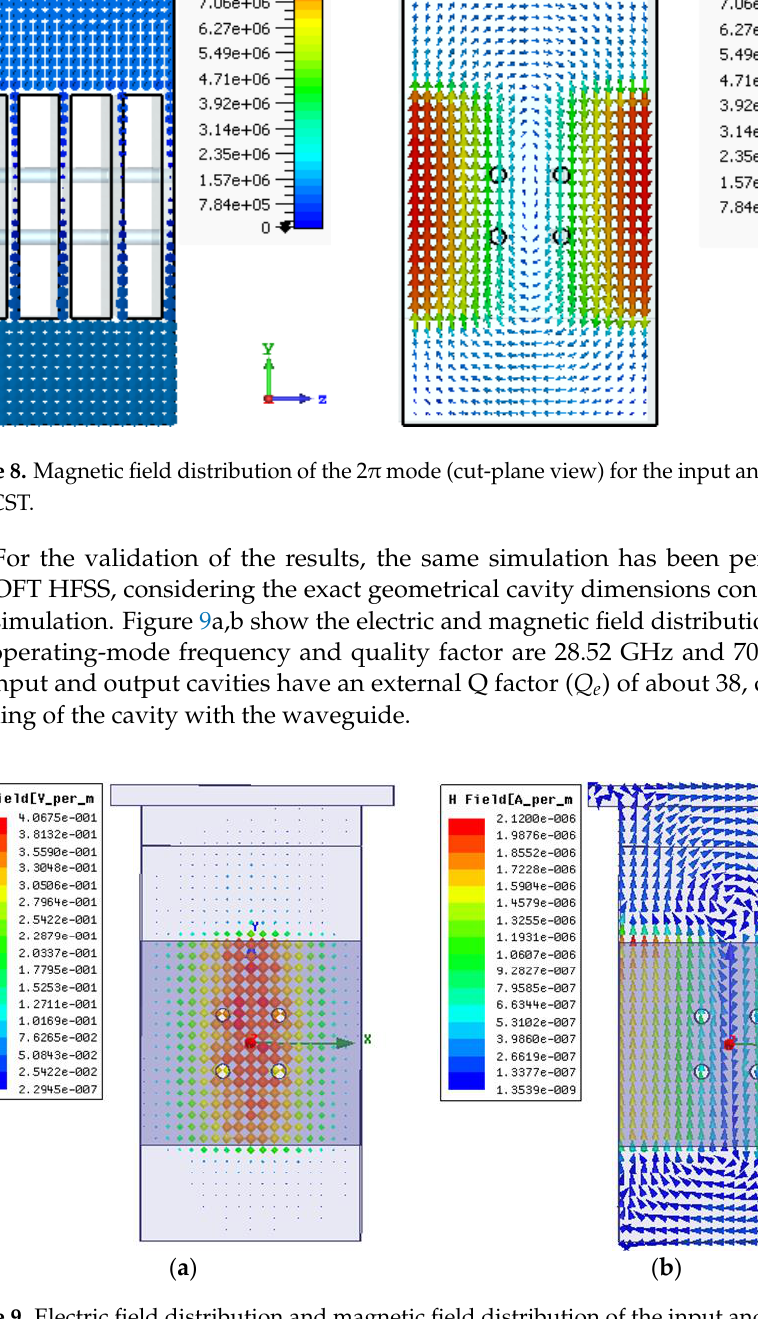
with HFSS; ( a ) E-field distribution; ( b ) M-field distribution.